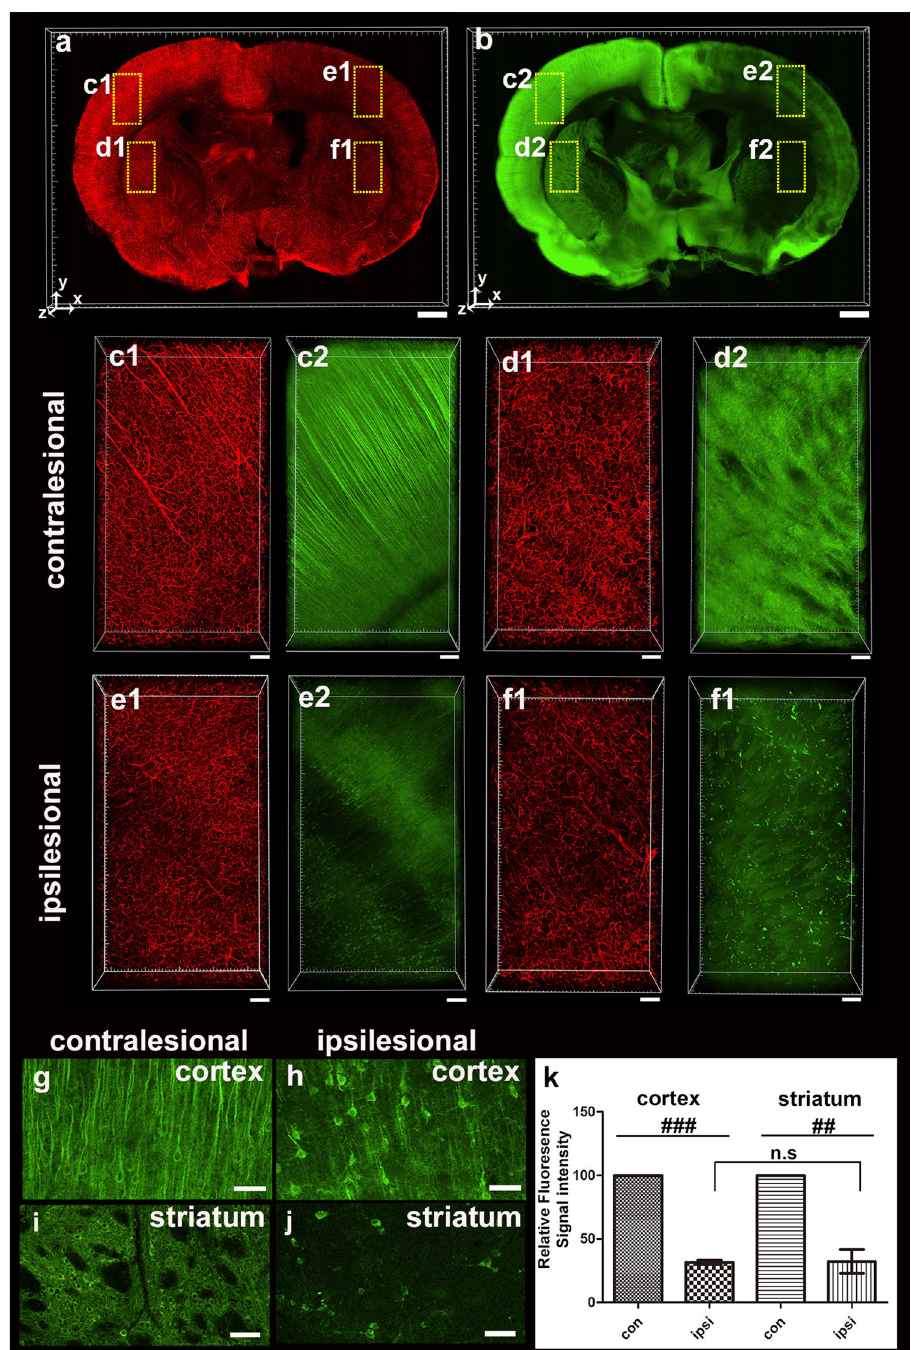
Figure 5. 3D visualization and quantification of MAP2-related immunofluorescence intensities 24 h after MCAO. ( a , b ) 3D reconstruction of the 0.5-mm-thick rat brain slice stained with lectin ( a ) and MAP2 ( b ). ( c – f ) Higher-magnification views of the boxed regions in ( a , b ) are shown. Vascular density loss and reduction in MAP2-positive fluorescence intensity were observed in the injured cortex and striatum compared with the contralateral side. ( g – j ) Morphological change of MAP2-positive cells in the injured cortex and striatum compared with the contralateral side. ( k ) Graph of the ratio of MAP2-related fluorescence intensity of the ipsilateral versus contralateral cortex 24 h after MCAO injury. MAP2-related fluorescence intensities in the infarction area were significantly decreased. Data are presented as the mean percentage relative to corresponding contralateral areas ± SEM (measures 3–4 cortical and striatal fields per animal, n = 3 animals). A significant difference was observed in fluorescence intensity of MAP2-positive cells between the contralesional and ipsilesional cortex, or striatum. No significant differences were observed in the fluorescence intensity of MAP2-positive cells between the ipsilateral cortex and the striatum. Paired t-test, FDR multiple comparison test, ### p < 0.001, ## p < 0.05. n.s = no significant differences. Scale bar = 1 mm in ( a , b ), 100 μm in ( c – f ), 50 μm in ( g – j